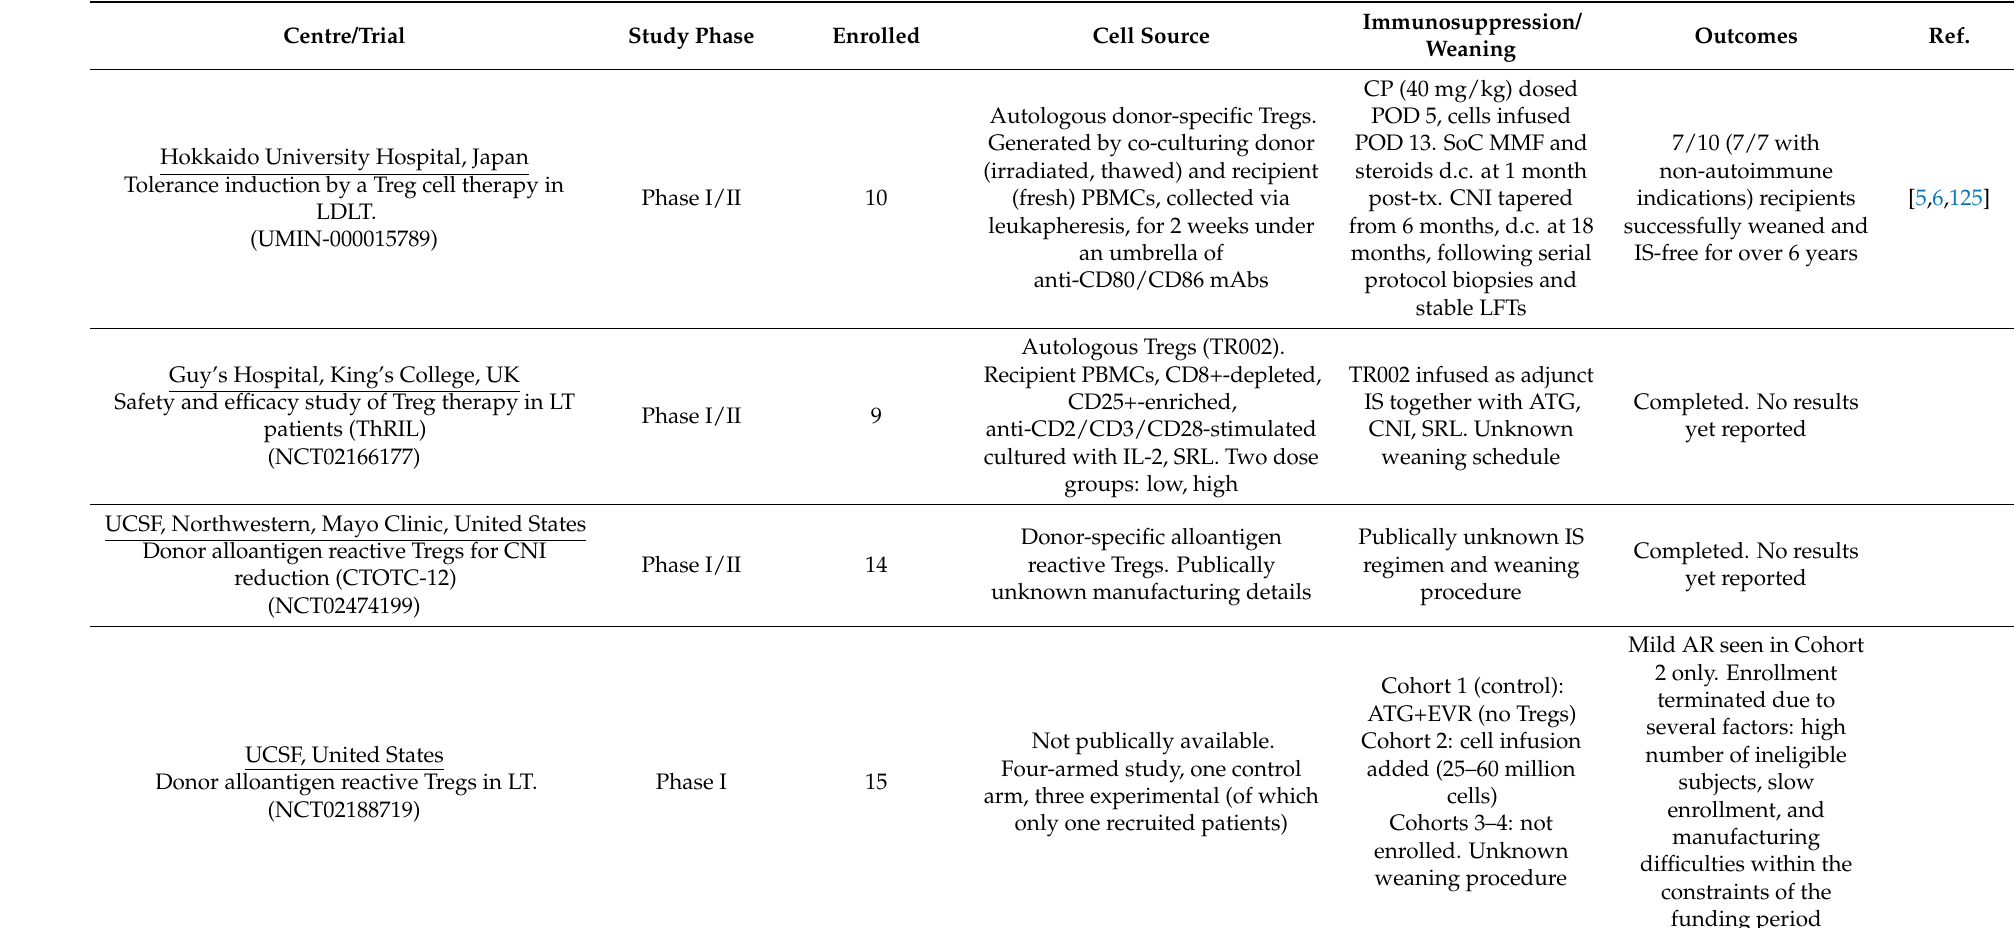
Table 2. Trials involving adoptive Treg therapies to actively induce liver transplantation